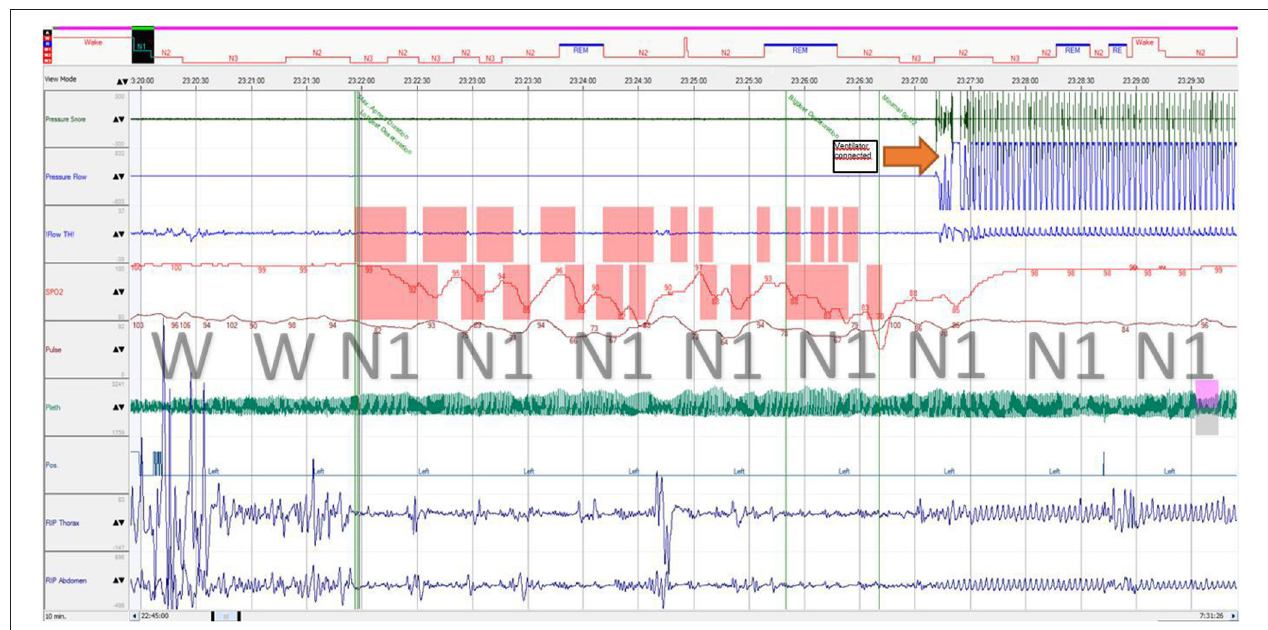
FIGURE 4 | Polysomnography fragment of sleep onset with central breathing impairment followed by assisted ventilation. Immediately after sleep onset, the patient developed breathing movement amplitude decrease (both thoracic and abdominal) with a “periodic breathing”-like pattern associated with progressive desaturation and hypercapnia, which is considered central (airflow was not obtained from the tracheostomy tube during self-breathing). REM, stage rapid eye movement; N1, stage 1 non-rapid eye movement; N2, stage 2 non-rapid eye movement; N3, stage 3 non-rapid eye movement; RIP, respiratory inductance plethysmography; Flow TH, oral thermistor flow sensor; Pleth,